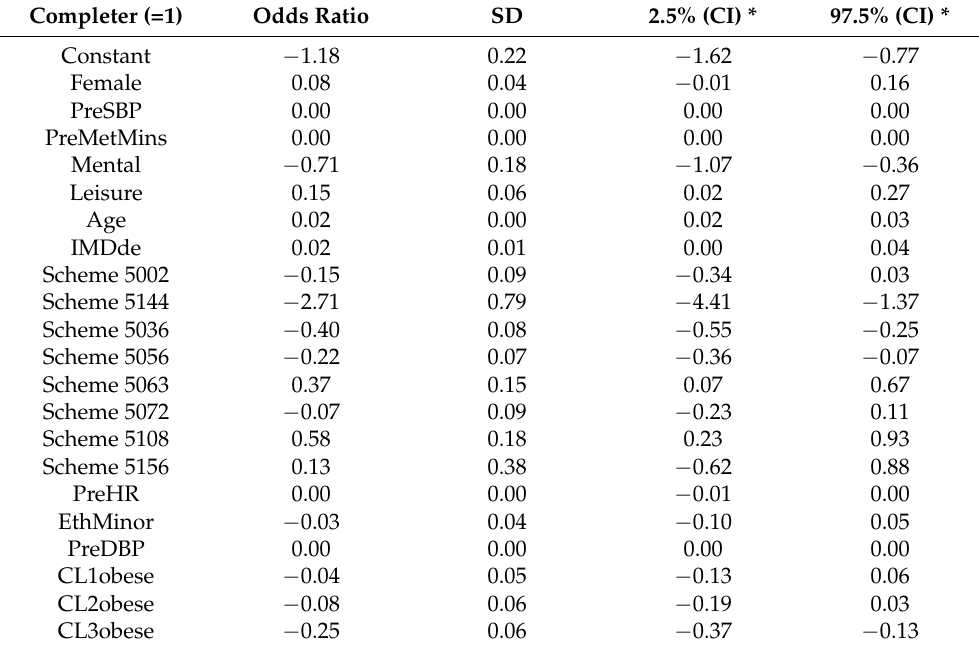
Table 1. Scheme completion (without interaction